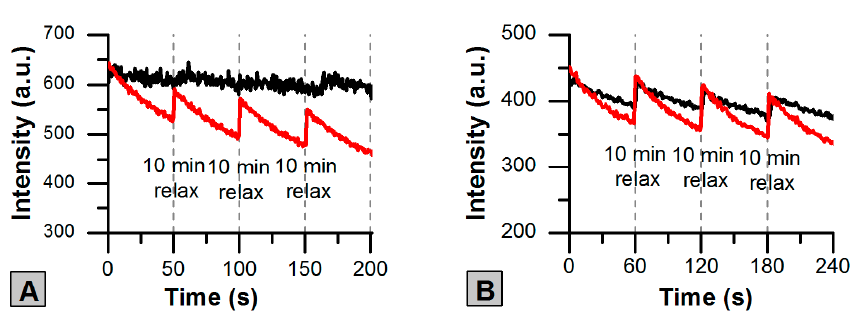
Figure 4. Photoswitching cycles of R1 (black) and R2 (red) SAASoti forms at 550 nm (300 mW/cm 2 ) irradiation (50 s) with 10 min relaxations. Time dependencies of the red fluorescence intensities at 590 nm. TBS buffer, pH 7.4. ( A ) Freshly prepared sample; ( B ) old SAASoti sample.